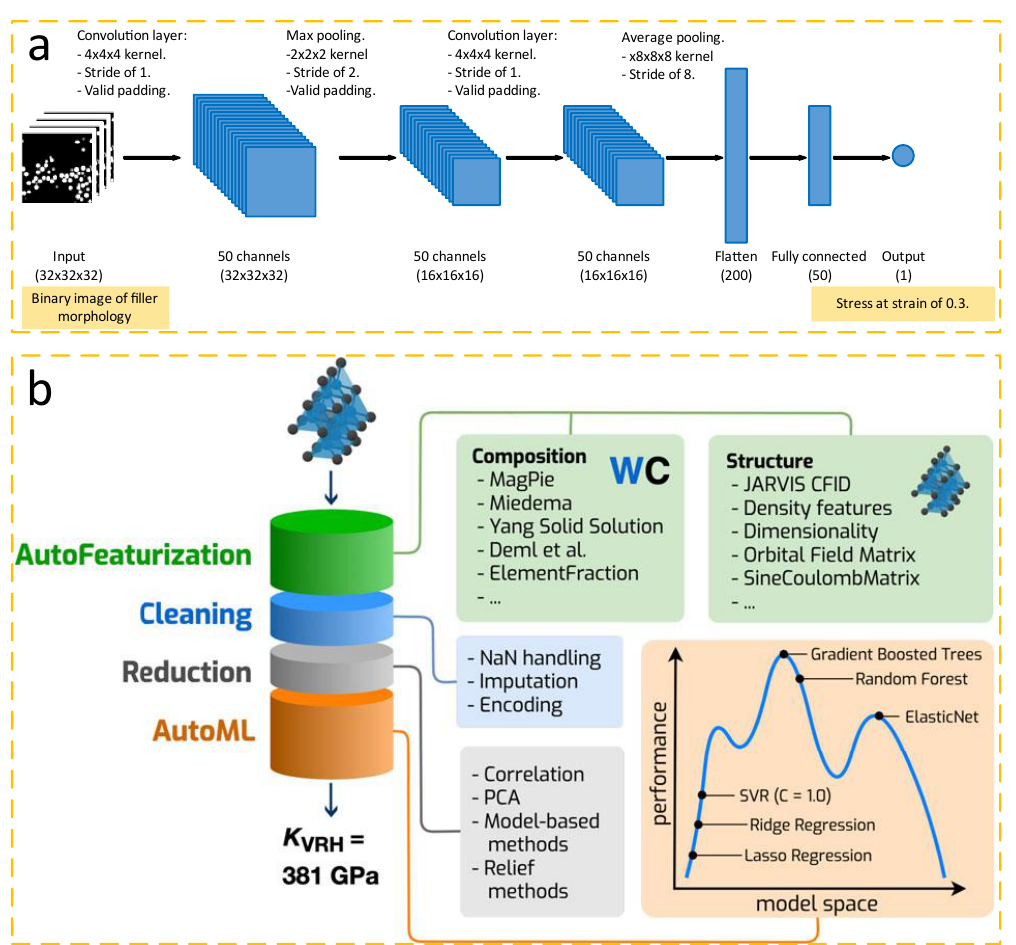
Figure 2. ( a ) CNN architecture. Reprinted from ref. [68] . ( b ) The AutoML+Matminer (Automatminer) pipeline. The pipeline can be applied to composition-only datasets, structure datasets, and datasets containing electronic band structure information. Once fit, the pipeline accepts one or more material primitives and returns a prediction of a material’s property. During auto featurization, the input dataset is populated with potentially relevant features using the Matminer library. Next, data cleaning and feature reduction stages prepare the feature matrices for input to an AutoML search algorithm. During training, the final stage searches ML pipelines for optimal configurations; during prediction, the best ML pipeline (according to internal validation score) is used to make predictions. Reprinted from Ref. [70] .